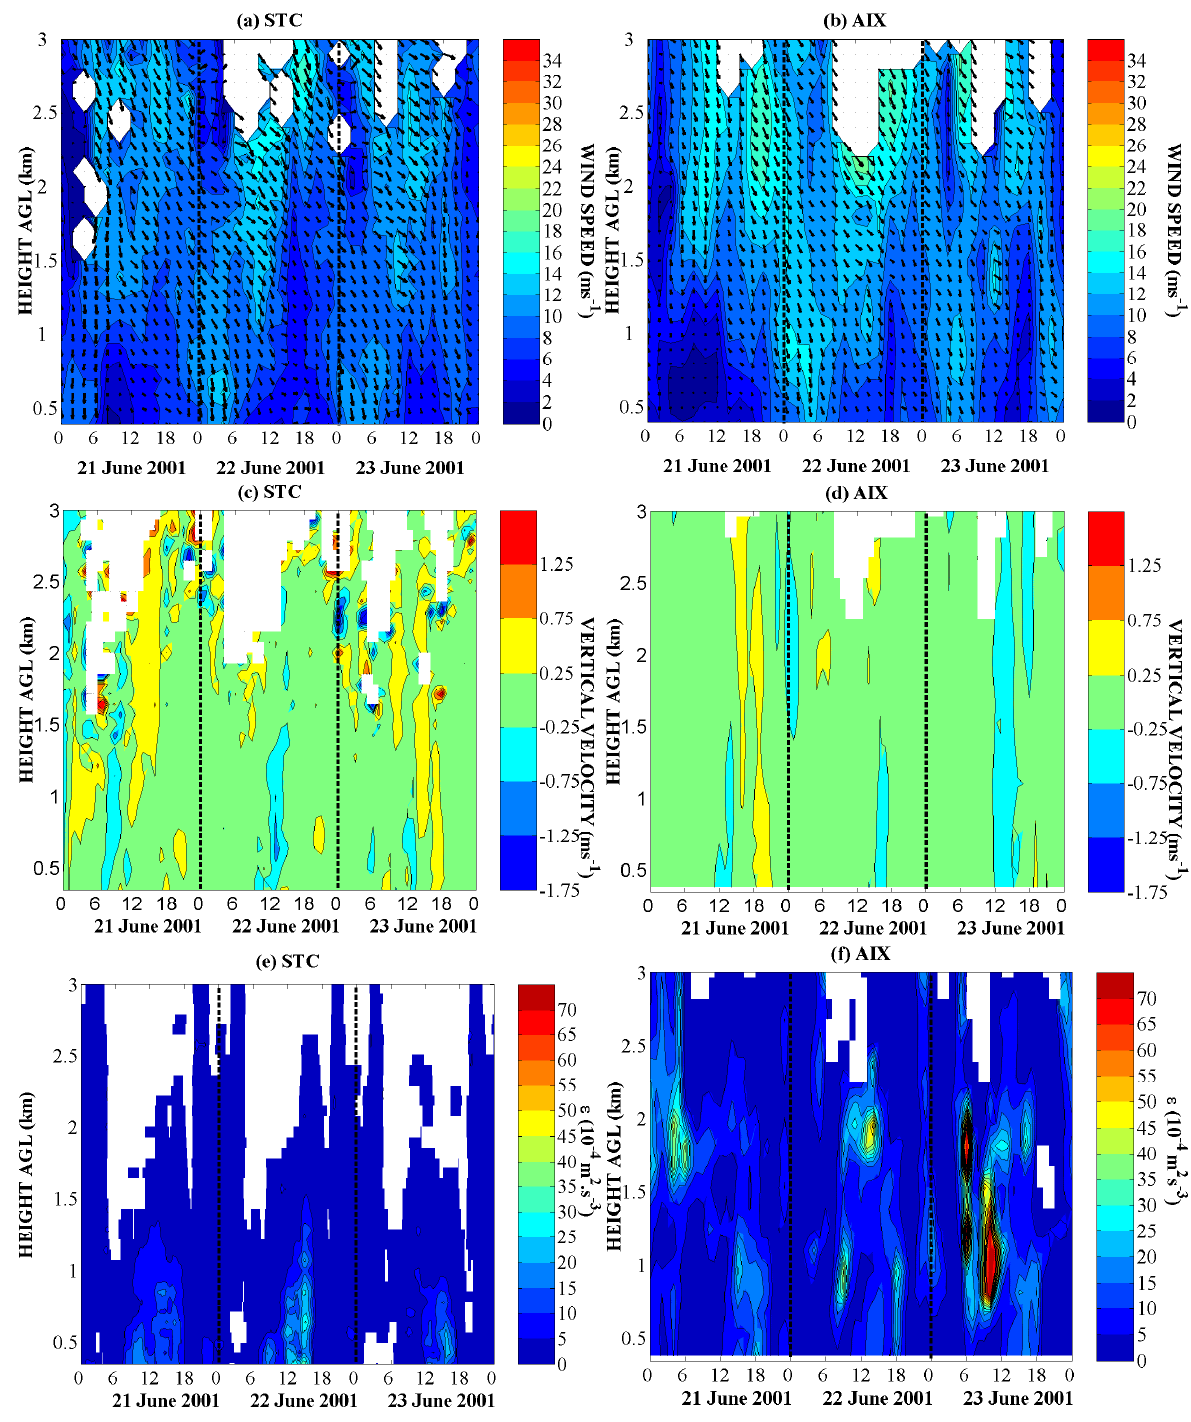
Fig. 4. Same as Fig. 3, at STC ( a , c , e ) and AIX ( b , d , f ) , during the 21–23 June 2001 Mistral event (from the ESCOMPTE Special Observing